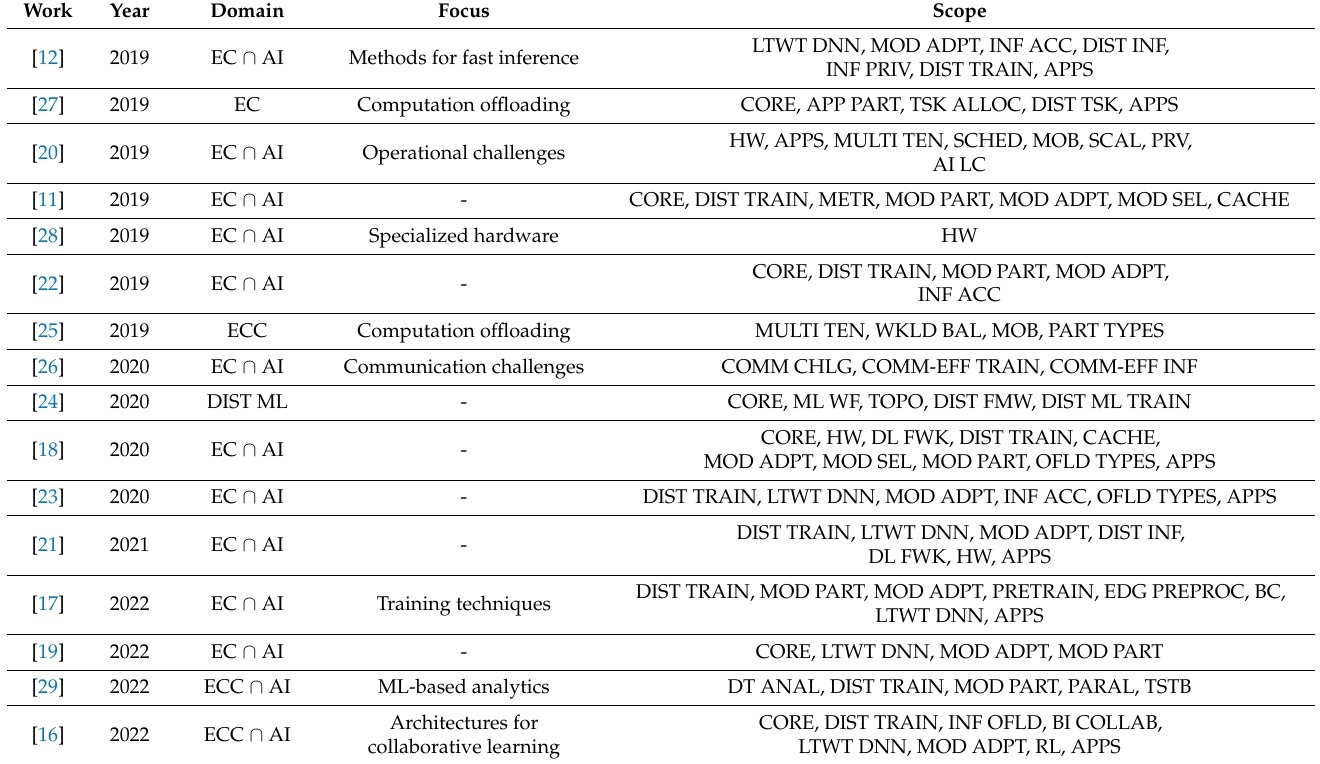
Table 1. Summary of the review papers pertinent to this work that exist in the